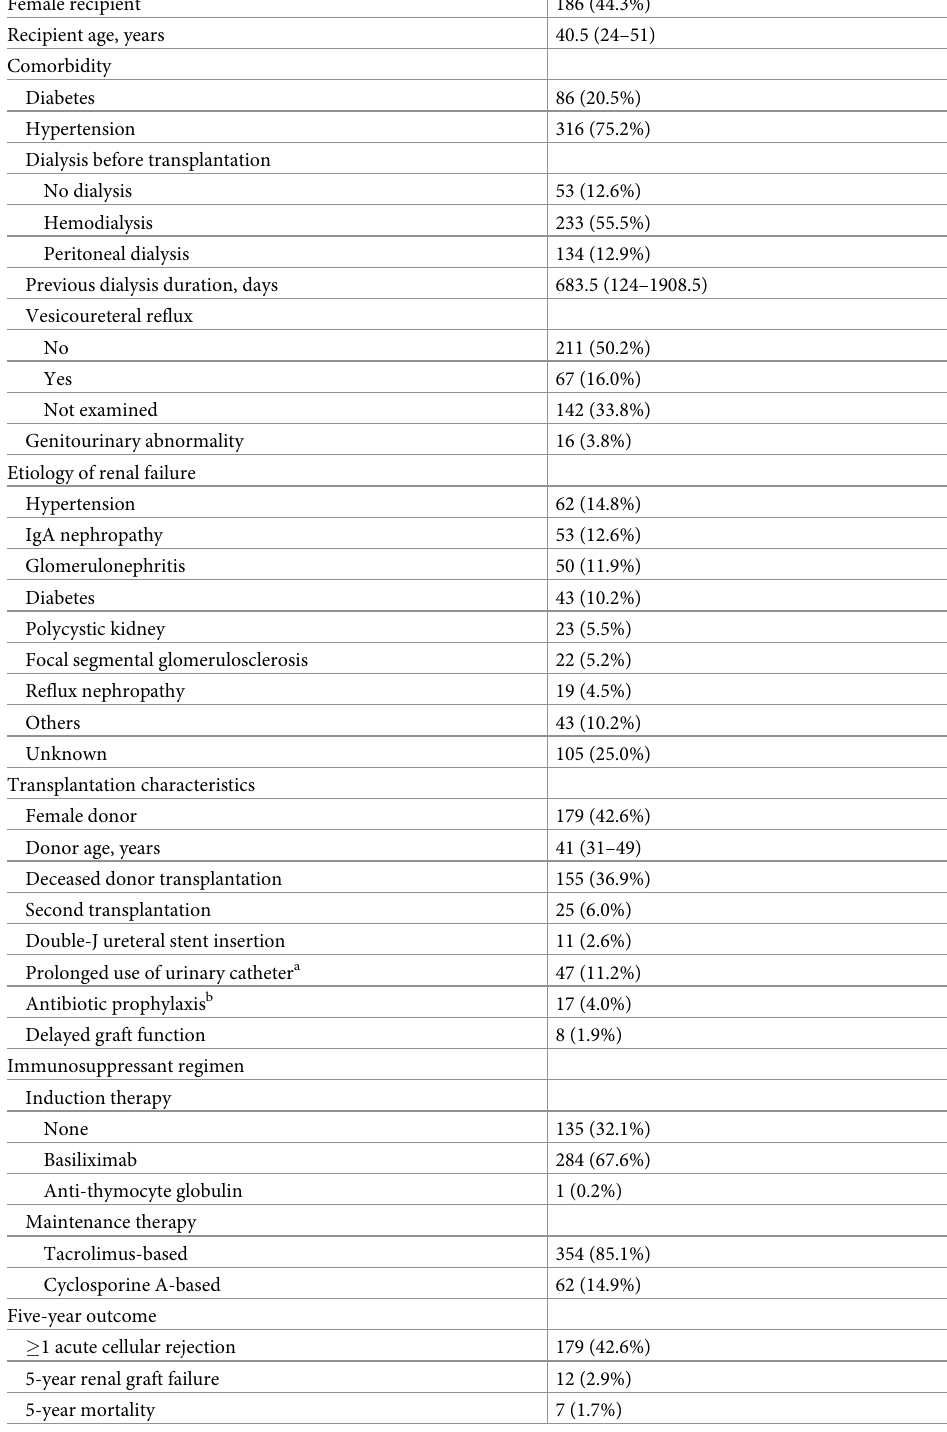
Table 1. Baseline demographics and clinical characteristics (n =